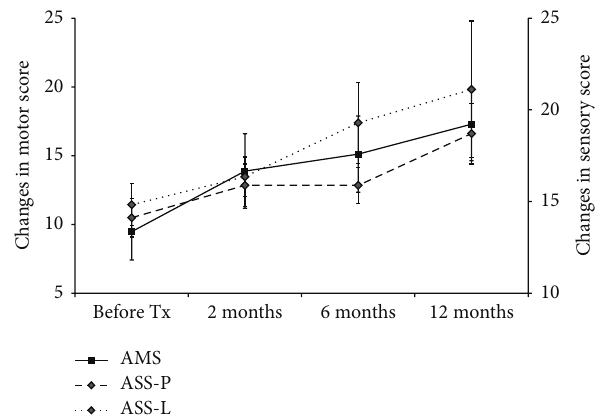
Figure 3: Changes in motor and sensory score over time in patients with complete cervical SCI following hNSPC transplantation. The cervical cohort of patients was followed for 1 year. The mean (mean ± SEM) change in AMS, ASS-P, and ASS-L is shown at each time point (before transplantation (before Tx) and 2, 6, and 12 months after